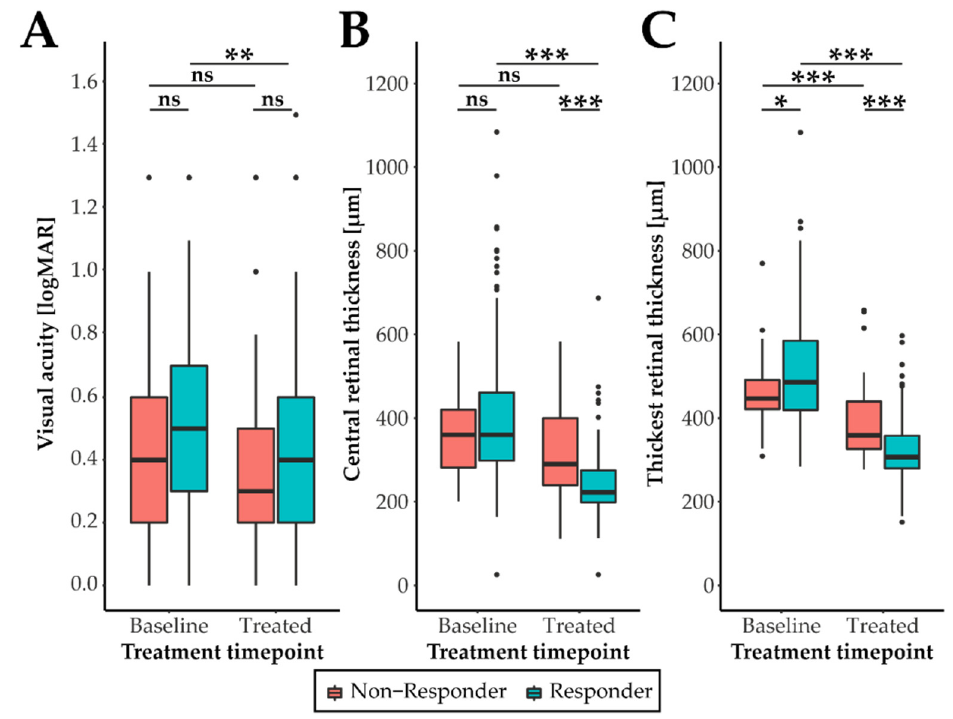
Figure 2. Clinical characteristics of non-responders and responders. The 179 study participants were grouped one month after three monthly anti-VEGF nAMD treatments in non-responders or responders according to the presence of retinal fluid or the strong improvement of clinical markers like central retinal thickness (decrease of > 200 µ m) or visual acuity (gain of >10 letters, logMAR < − 0.2). This resulted in 128 responders and 51 non-responders. Shown are the measurements of visual acuity ( A ), central retinal thickness ( B ) and thickest retinal thickness ( C ) at baseline and after treatment. A pairwise Wilcoxon test, adjusted for multiple testing, was performed to determine significant differences between the two groups. Adjusted p -value thresholds: ns ≥ 0.05, * < 0.05, ** < 0.01, and *** < 0.001. In ( A ), a single outlier of the responder group with visual acuity of 2.2 logMAR at baseline is not depicted to facilitate optimal scaling of the data.